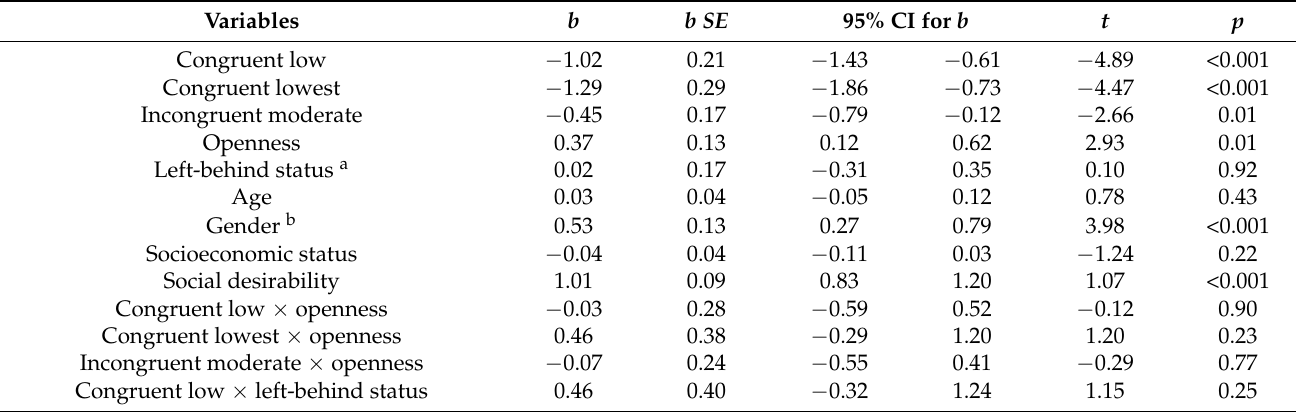
Table 4. Regression analysis predicting subjective well-being from warmth profiles, openness to experience, and left-behind status.